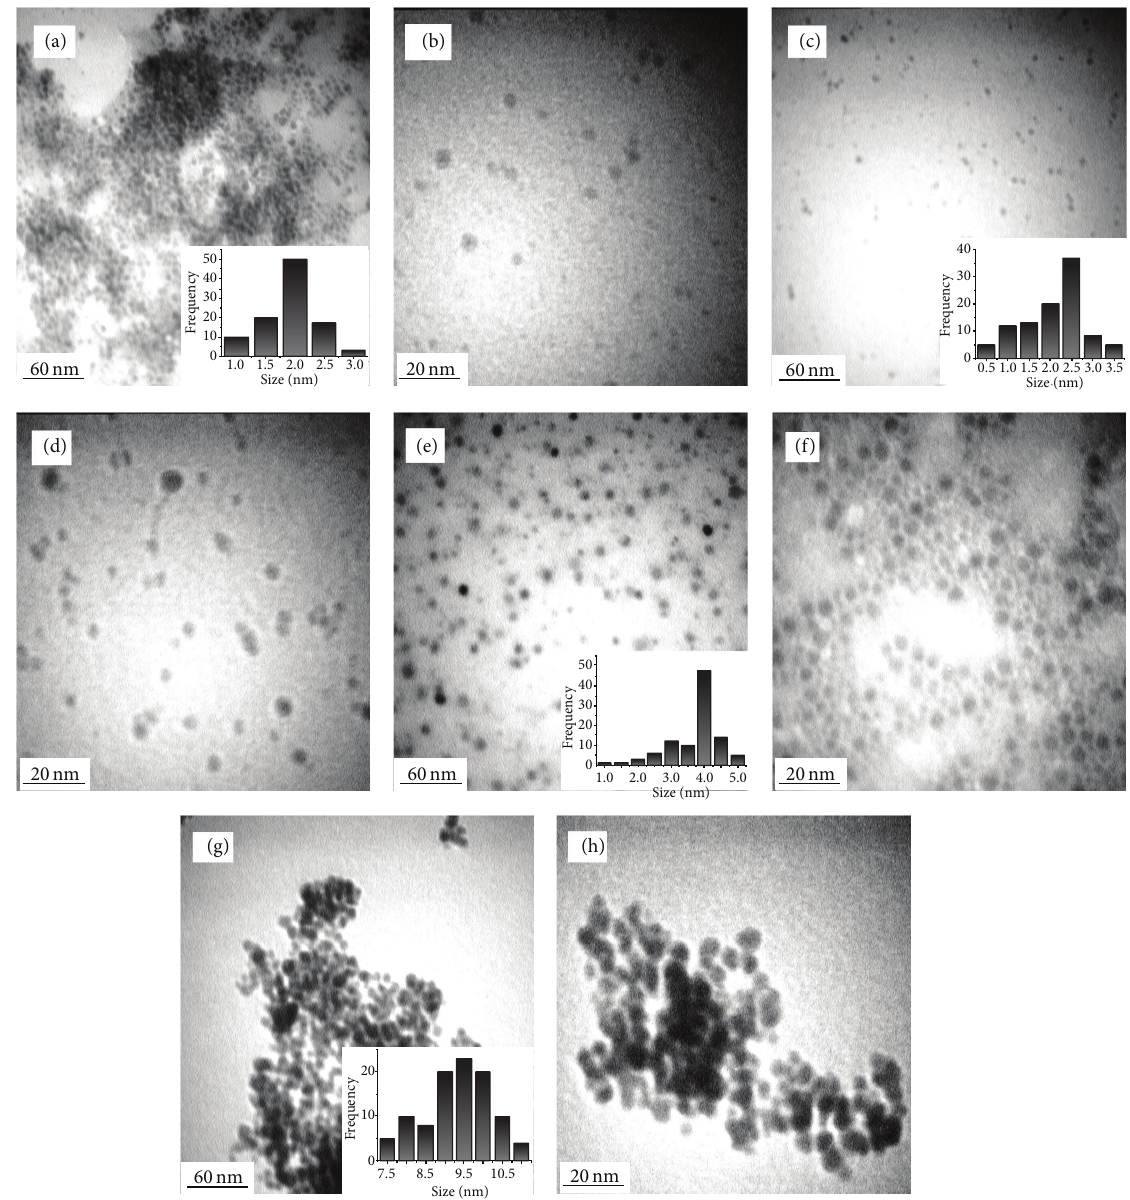
Figure 3: TEM micrographs of as-synthesized nanoparticles and corresponding size distributions: (a) W1, (b) W1 at higher magnification, (c) W2, (d) W2 at higher magnification, (e) W3, (f) W3 at higher magnification, (g) W4, and (h) W4 at higher